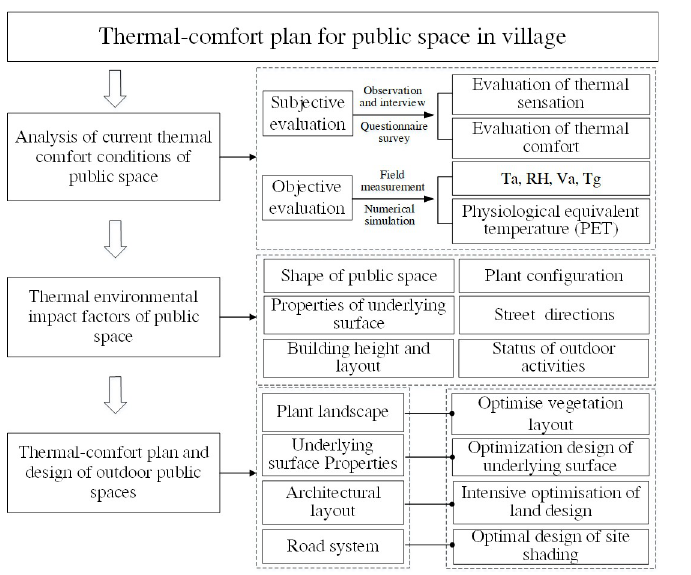
Fig 22. Thermal-comfort plan for the village’s public